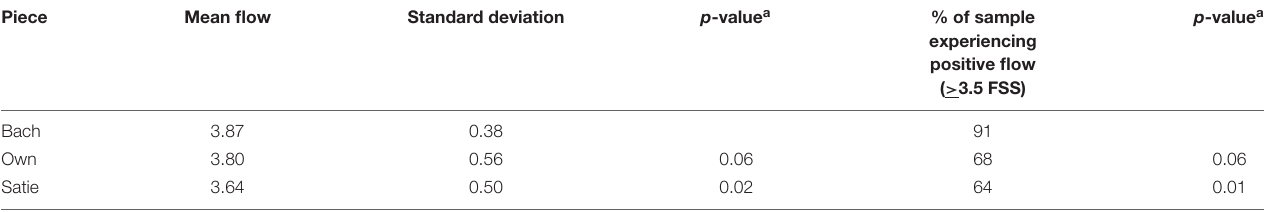
p -value a experiencing positive flow ( > 3.5 FSS)